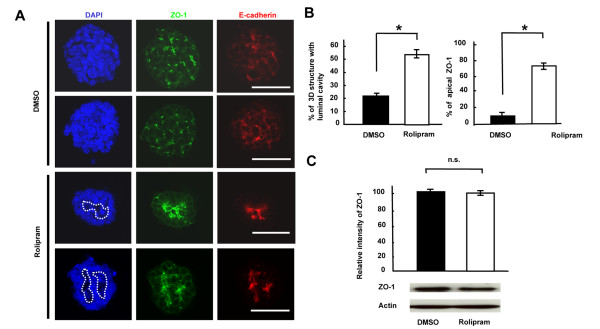
Formation of luminal cavities and tight junctions by PDE4 inhibitor in HCT116 cells grown in 3 DC.(A) The signals for ZO-1 and E-cadherin in HCT116 cells treated with DMSO alone or rolipram at day 6 in 3 DC. Nuclear DNA, blue; ZO-1, green; E-cadherin, red. Dots represent luminal cavities. Scale bar = 50 μm. (B) The ratios of 3-D structures with luminal cavity (left panel) and apical ZO-1 signal (right panel). White bar represents a relative intensity of the signal for 3 DC HCT116 cells treated with rolipram, normalized by the signal for 3 DC HCT116 cells treated with DMSO alone (black bar). *, P < 0.0001. (C) Western blotting of ZO-1 for 3 DC HCT116 cells treated with DMSO alone or rolipram at Day 6 (lower panel) and the quantitative analysis of ZO-1 expression level (upper panel). White bar represents a relative intensity of the signal for 3 DC HCT116 cells treated with rolipram normalized by the signal for 3 DC HCT116 cells treated with DMSO alone (black bar). n.s., not significant.